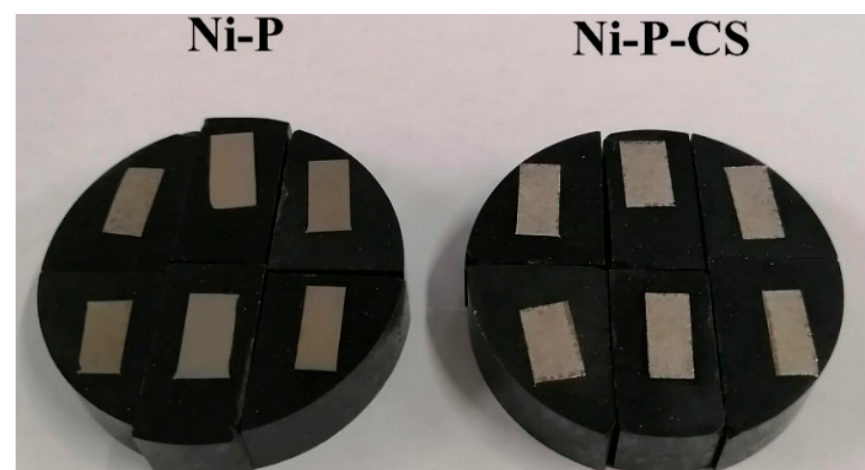
Figure 4. Ni-P coating and Ni-P-CS composite coatings.